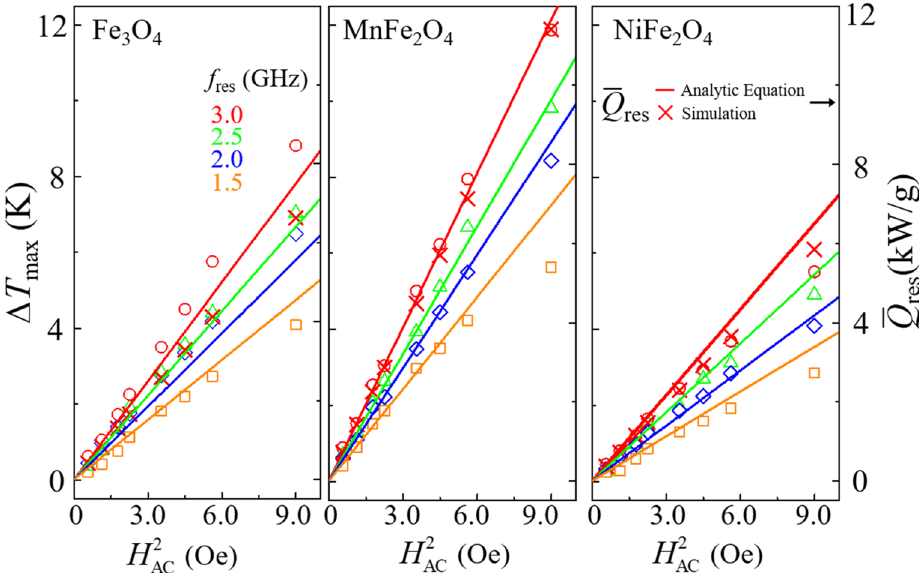
2 Figure 4. Plots of maximum temperature increments ∆ T max as function of H AC for Fe 3 O 4 (left panel), MnFe 2 O 4 (middle panel), and NiFe 2 O 4 (right panel) materials, as obtained at resonance with each of different frequencies of f AC = 1.5, 2.0, 2.5, and 3.0 GHz. The red solid lines and the cross symbols indicate the steady-state energy- ¯ Q dissipation rate at resonance res obtained from the analytic equation [Eq. (1)] and the simulation data for f AC = f res = 3.0 GHz,